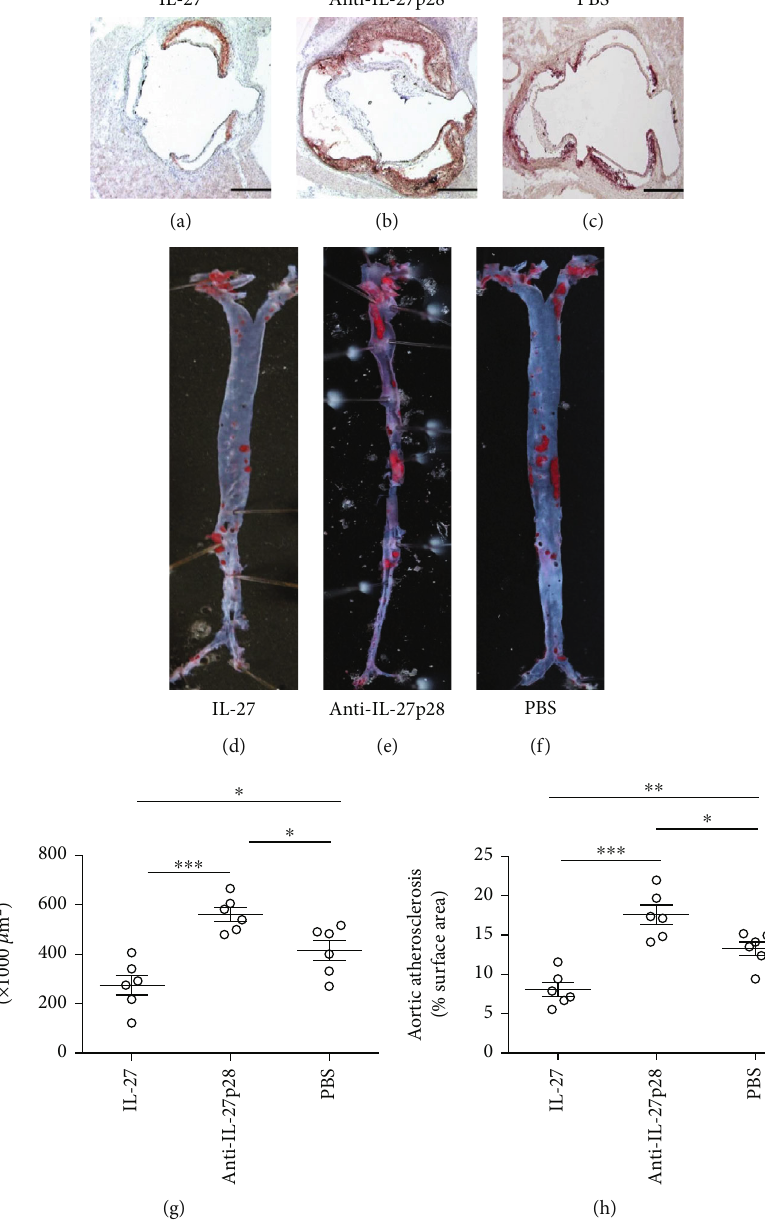
Figure 1: Recombinant IL-27 inhibited the initiation of atherosclerosis. (a), (b), and (c), Representative photomicrographs show Oil Red O and hematoxylin stained aortic root sections from groups treated with IL-27, anti-IL-27p28-Ab, or PBS while they were fed a high-fat diet for 8 weeks, respectively. (g) Data from group (a), (b), and (c) are shown. A black bar represents 200 μ m. (d), (e), and (f) Representative photomicrographs show Oil Red O stained the descending aortas from groups treated with IL-27, anti-IL-27p28-Ab, or PBS while they were fed a high-fat diet for 8 weeks, respectively. (h) Data from group (d), (e), and (f) are shown. ∗∗∗ P < 0 : 001 , ∗∗ P < 0 : 01 , ∗ P < 0 : 05